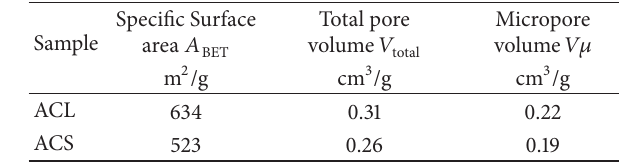
− 196 ∘ C (Figure 1). The isotherm of activated carbon prepared from leaf (ACL) as well as stem (ACS) shows similar shape,